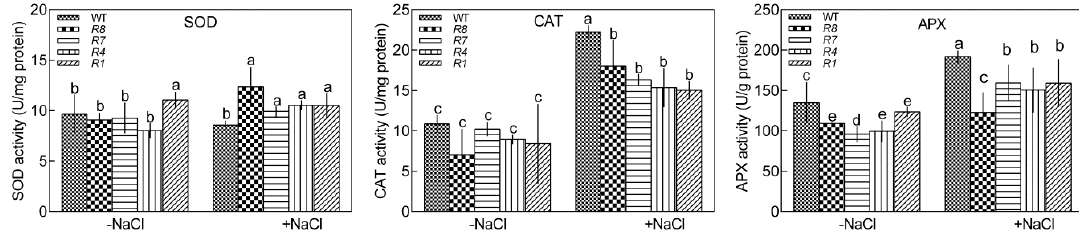
Figure 8. Effect of NaCl on activities of superoxide dismutase (SOD), catalase (CAT), and ascorbate peroxidase (APX) in wild-type (GL1) and CPK12 -RNAi lines. Seven-day-old seedlings were transferred to MS medium supplemented with or without 100 mM NaCl for 10 d. The activities of antioxidant enzymes were analyzed. Each column shows the mean of three replicated experiments and bars represent the standard error of the mean. Columns labeled with letters in the same group denote significant difference at p < 0.05.